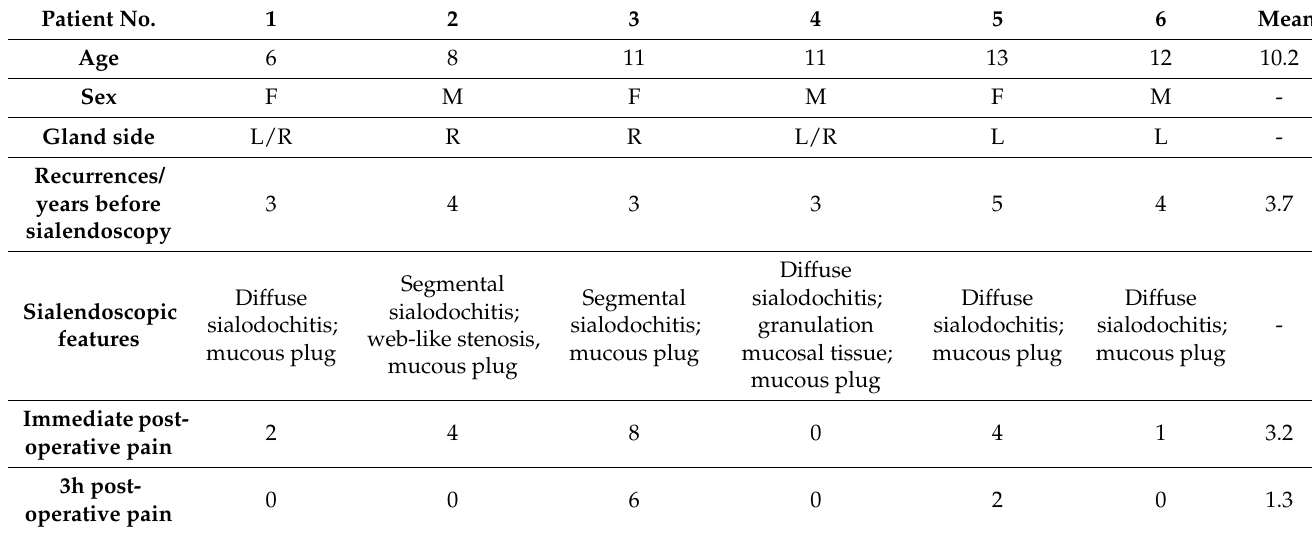
Table 1. Clinical and sialendoscopic data of